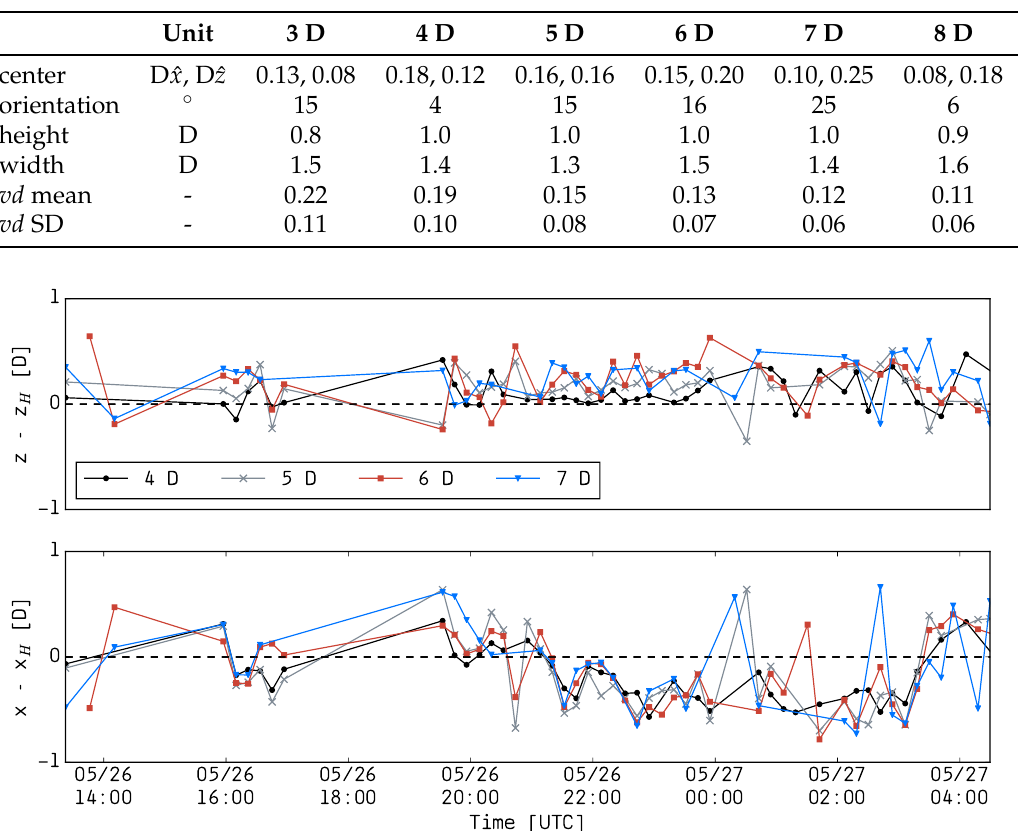
Figure 10. Time series of wake center position in the vertical ( top ) and horizontal ( bottom ) directions as estimated from the field measurements, for the intermediate downstream distances between 4 and 7 D. The dashed line marks the hub position ( x H , z H ) = (0,